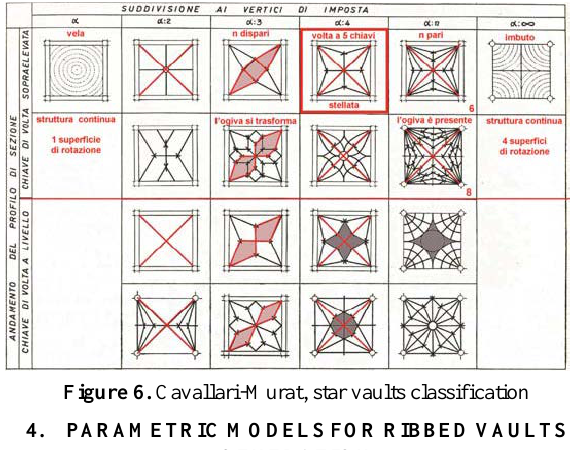
Figure 7 . Villard geometric rule for arches generation